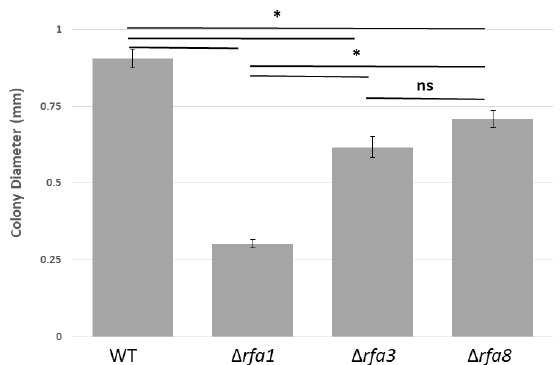
Figure 2. Colony size comparison between LH101 (wild-type: WT) and LH140 (Δ rfa1 ), LH134 (Δ rfa3 ), and LH136 (Δ rfa8 ). Plates were incubated for 7 days. Colony diameter was measured using ImageJ (Version 1.8.0_112, National Institutes of Health, Bethesda, MD, USA) [28]. * p < 0.05, analysis of variance (ANOVA) with Tukey’s Honest Significant Difference (HSD), n = 22–40 colonies total over 2 biological replicates. Error bars represent the standard error of the mean (SEM). ns = not significant.